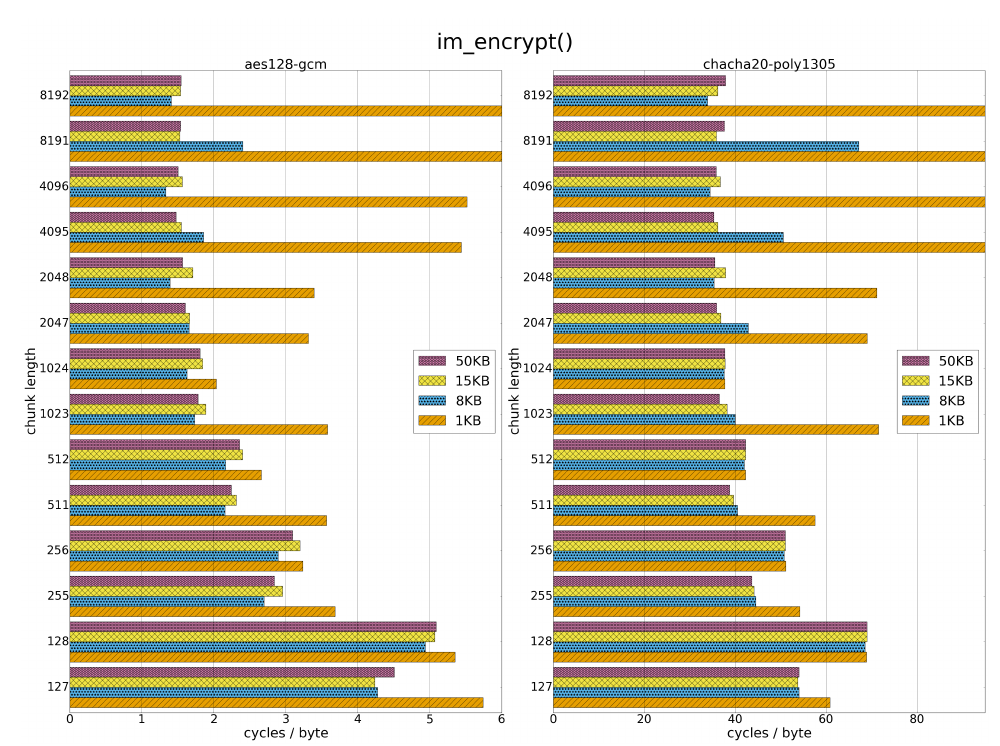
Figure 1: Performance measurements (lower is better) of the encrypt function ( im_encrypt() ) in libInterMAC for a number of chunk lengths and message lengths. Each chart shows the number of clock cycles per byte using either AES - GCM (left chart) or ChaCha20 - Poly1305 (right chart) as the internal nonce-based AE scheme. The number of clock cycles per byte, for each combination of chunk length and message length (of size 1KB, 8KB, 15KB or 50KB, as indicated by four distinct label colors/patterns), is computed by taking the minimum of 25 independent averages where each average is calculated over 100 samples. AES - GCM is implemented using AES-NI and CLMUL instructions, while ChaCha20 - Poly1305 is done purely in software (cf. Section 4.4). Some bars for the 1KB message category are truncated to increase readability. Left chart: the value for a chunk length of 8191/8192 is approximately 10 cycles/byte. Right chart: the value for chunk lengths of 4095/4096 or 8191/8192 are approximately 140 cycles/byte and 270 cycles/byte,